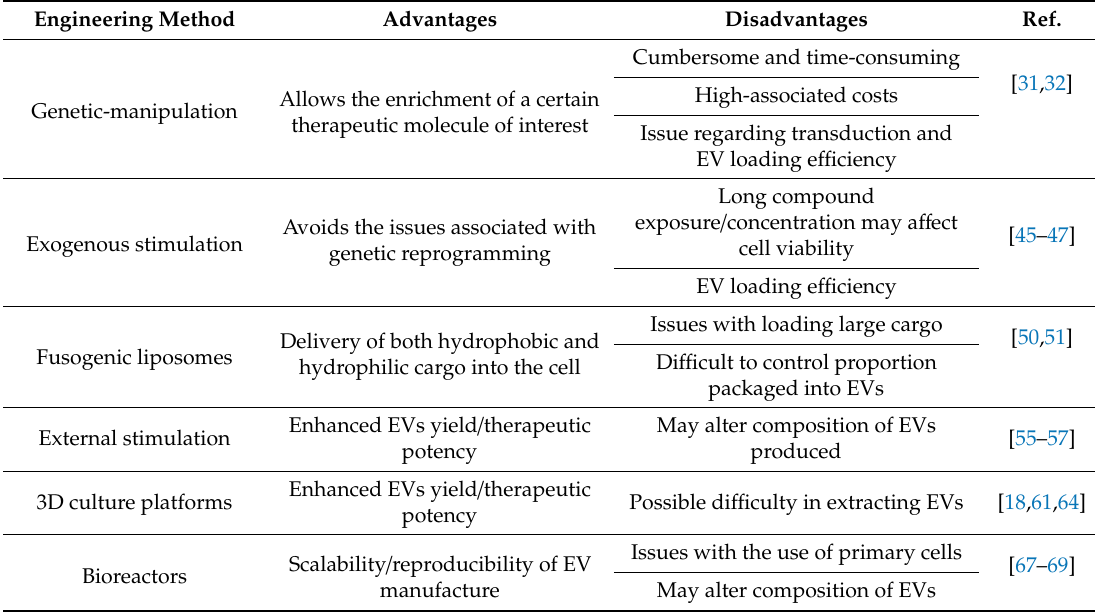
Table 1. Methods to re-engineer the parental cell to modulate